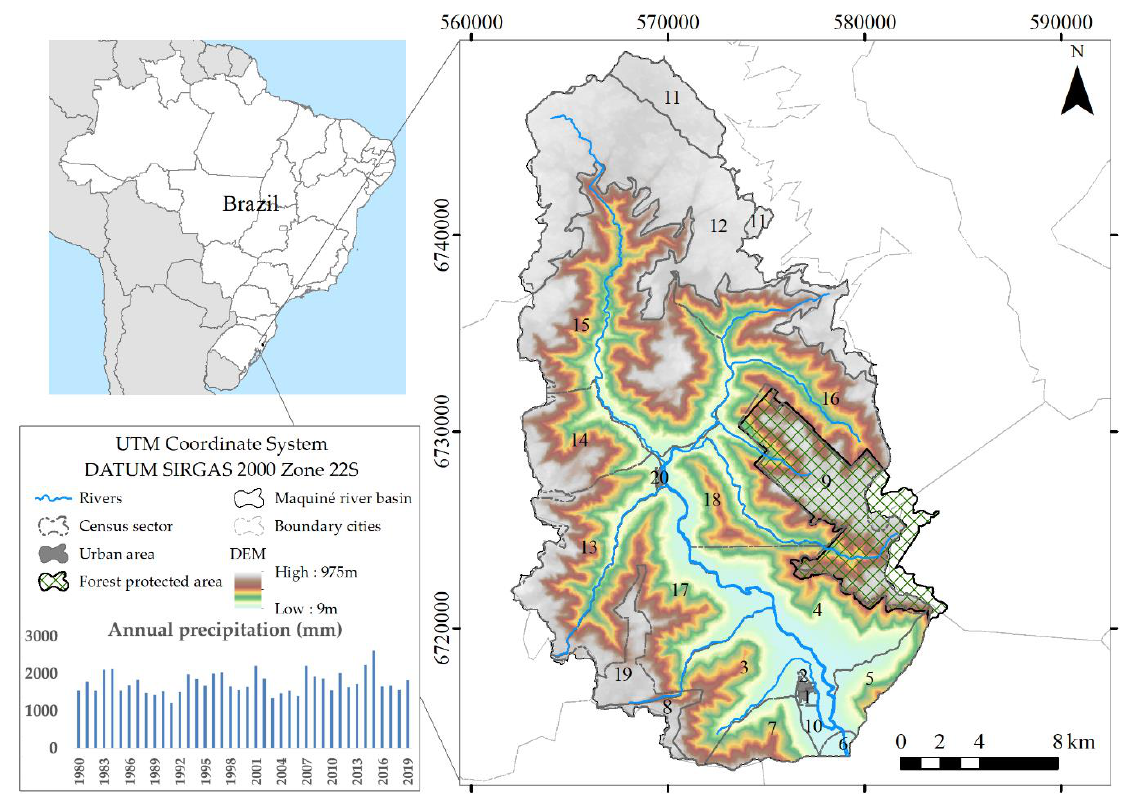
Figure 1. Location of the Maquiné River Basin, census blocks (CB), DEM (digital elevation model), and annual precipitation (mm).